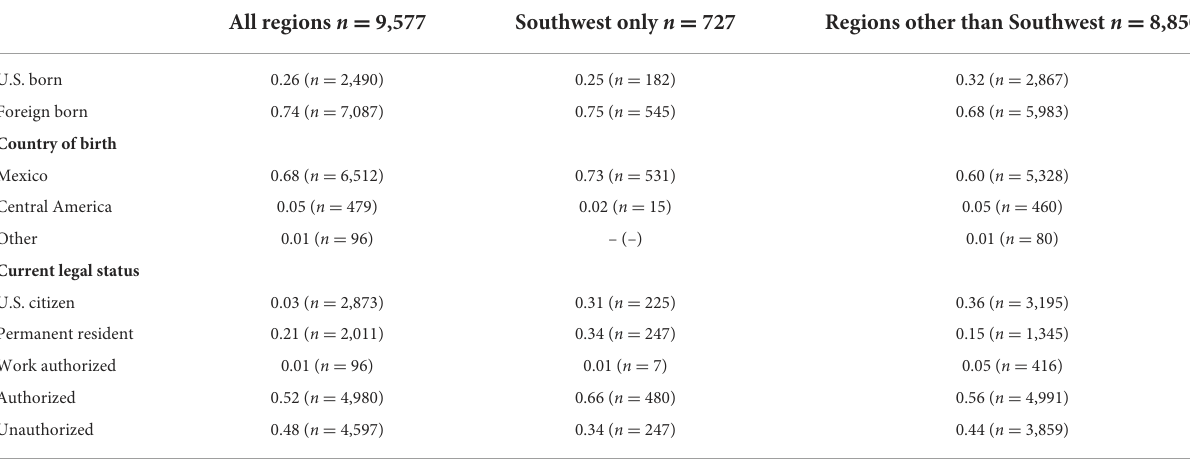
TABLE 2 Place of birth & legal status of farmworkers interviewed in NAWS, Southwest compared to other regions 2013–2016 a